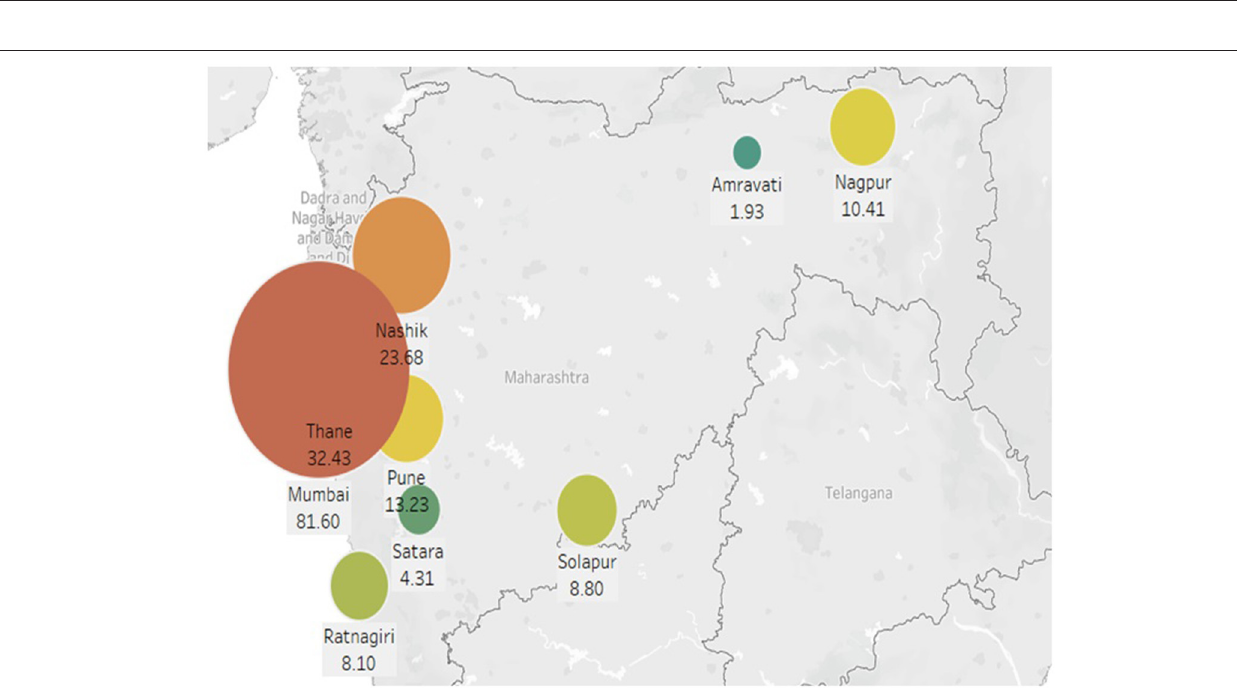
FIGURE 8 | Predictions for Facebook prophet model (X-axis: Date and Y-axis: Dengue cases).